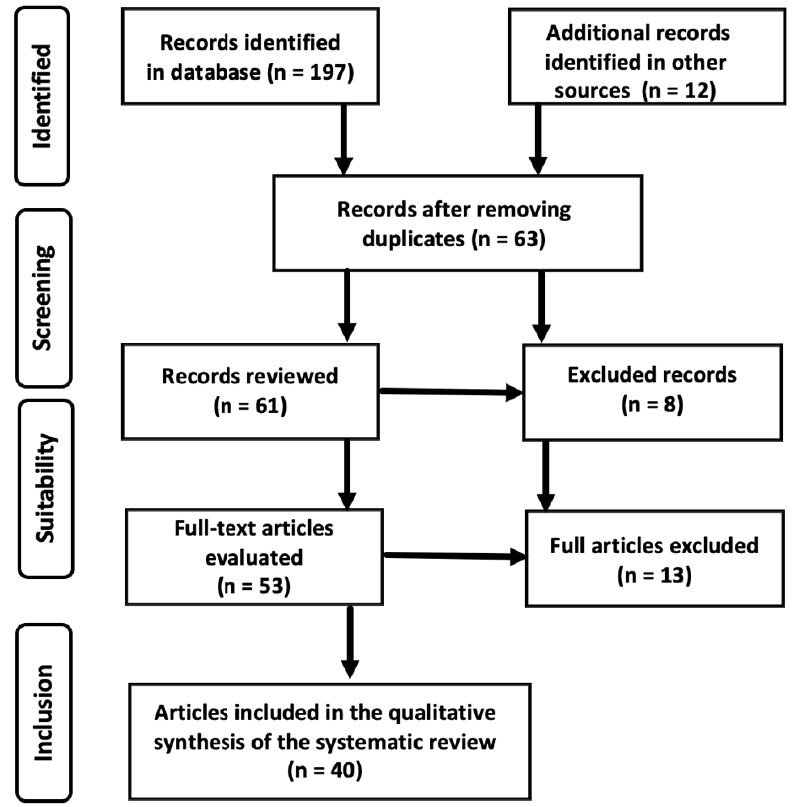
Figure 3. Criteria for article selection.